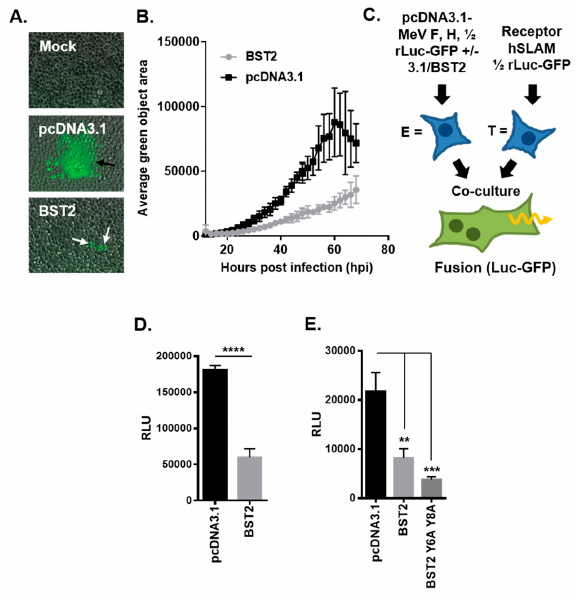
Figure 2. MeV cell–cell fusion is inhibited by BST2. ( A/B ) The average green object size (syncytia) in high MOI (2), MeV-GFP infected 293-hSLAM cells, transfected with the indicated pcDNA3.1-based expression constructs, was quantified at the indicated times post infection using an Incucyte imager. ( A ) Representative micrographs taken at 24 h post infection (black arrows, typical syncytia in pcDNA3.1 transfected; white arrows, smaller foci with pcDNA3.1-BST2). ( C ) The MeV cell–cell fusion assay involves separate transfection/treatment of effector E and target T populations prior to co- culturing, as indicated. Fused cells can be visualized and quantified due to reconstitution of the rLuc- GFP reporter. ( D ) The HEK293T MeV effector cells, expressing MeV fusion (F) and haemagglutinin (H), were cotransfected with the indicated pcDNA3.1-based expression constructs before cell fusion was quantified (by assaying Renilla luciferase activity 16 h after co-culturing with hSLAMF1-positive